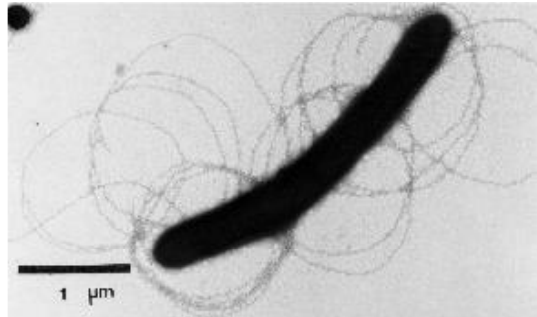
Figure 1. Transmission electron micrograph of a negatively stained cell of T. bryantii strain mel9 T grown on minimal medium containing 0.5% glucose at 65 °C. Bar markers indicate size ( 1 μm ).